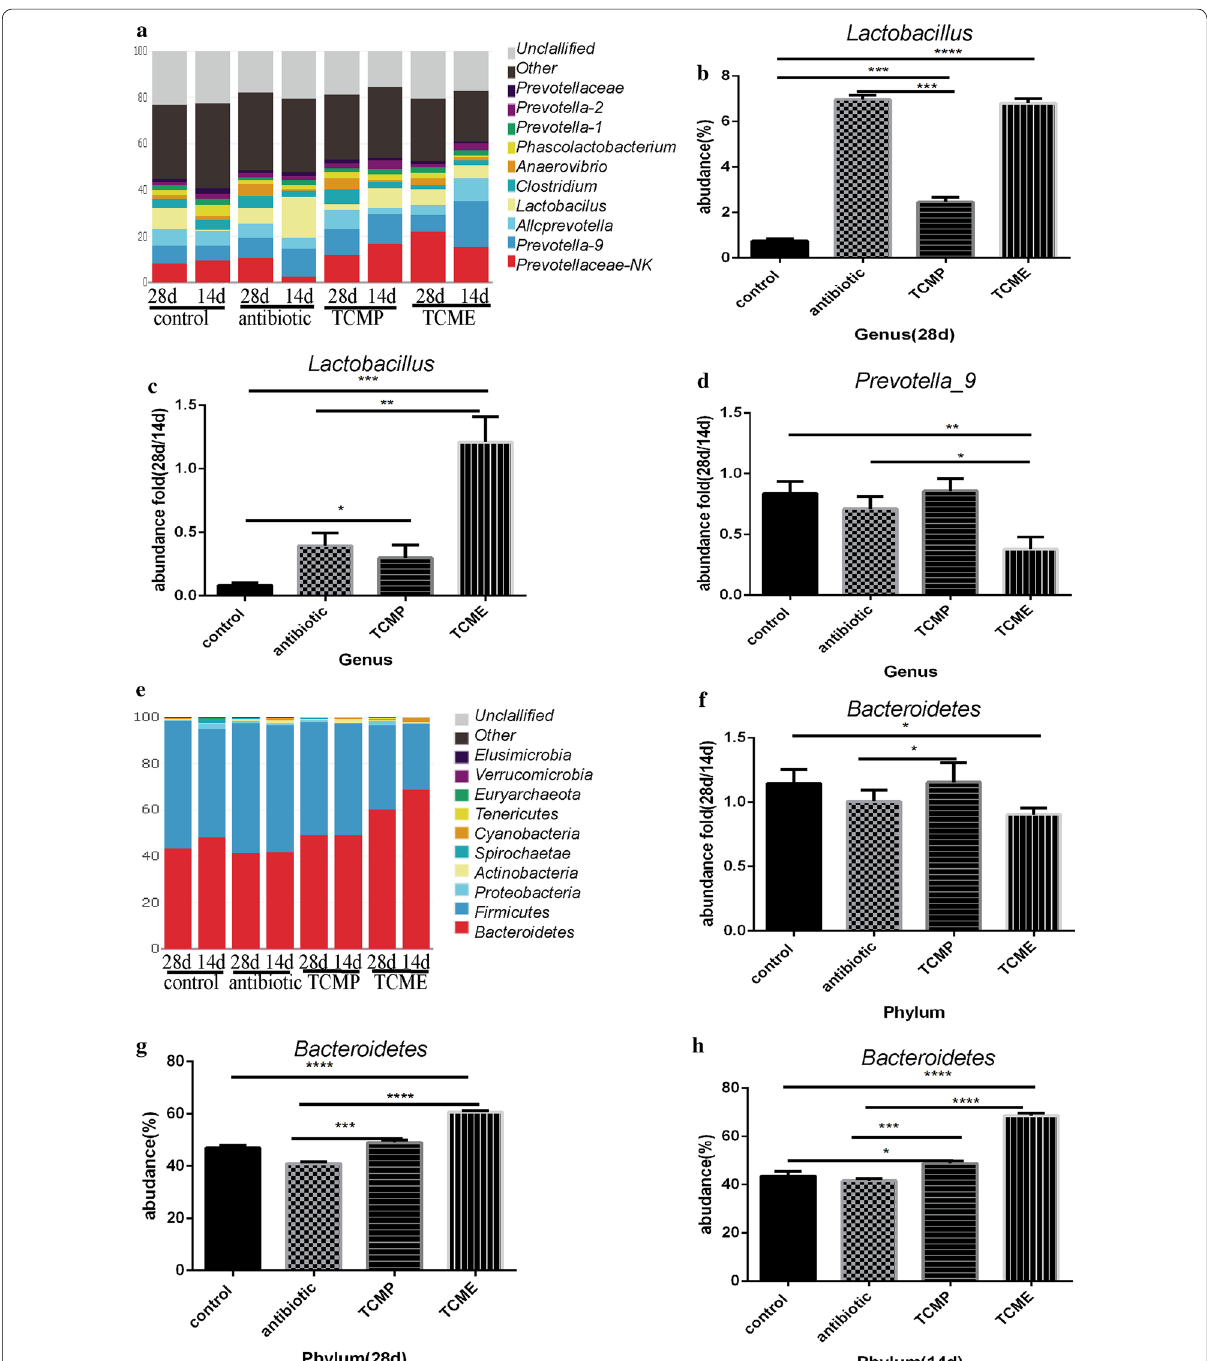
Fig. 6 Effect of coix seed on the composition of cecal microbiota with respect to genus and phylum. a1 Effect of coix seed on the composition of cecal microbiota with respect to genus in weaned pigs. a2 Abundance of genus Lactobacillus. a3 Fold abundance of genus Lactobacillus (28D/14D). a4 Fold abundance of genus Prevotella - 9 (28D/14D). b1 Effect of coix seed on the composition of cecal microbiota with respect to phylum in weaned pigs. b2 Fold abundance of phylum Bacteroidetes (28D/14D). b3 Abundance of phylum Bacteroidetes . b4 Fold abundance of phylum Bacteroidetes (14D) (* p < 0.05; ** p < 0.02; *** p < 0.01, **** p <